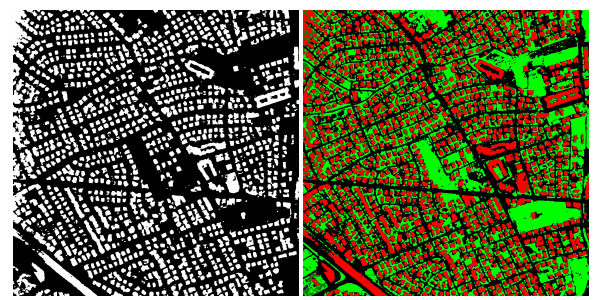
Figure 4: Left: High objects mask, right: final classification, red: buildings, green: low vegetation, dark green: trees, blue: water 3 THREE-DIMENSIONAL CITY